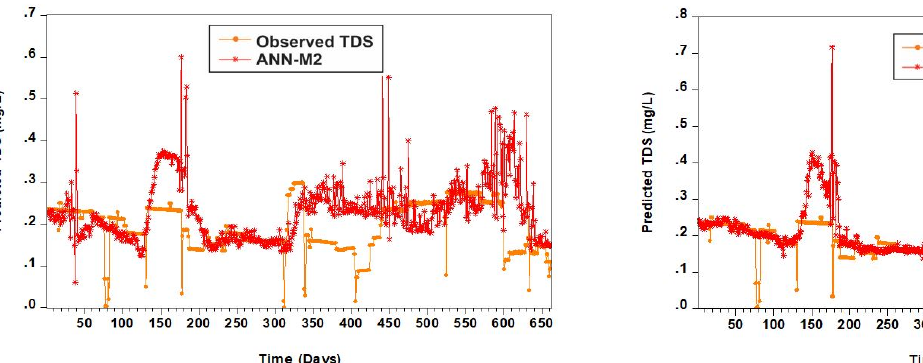
Figure 6. Time series plot for ANN-M2, ANFIS-M2, SVM-M2, and MLR-M2. According to the time-series plots, it was evident that the best predictive model was M1, since the prediction trend was closer to the observed TDSt. Similarly, the trends of the observed and predicted values for ML models were found to be close to each other. The MLR models, on the other hand, revealed a discrepancy in the trends of observed and predicted values. Furthermore, the time series of the models differ from one combination to the next, implying that the vibrational pattern of the M models is determined by how they capture the relationship between the observed and target parameters. From the above figures, it can be justified that SVM-M1 captures the pattern of the time series more than the other models, with MLR-M2 being the worst model. The uniqueness of the good- ness-of-fit could be indicated in the radar chart. On the other hand, it is important to in- volve two or more performance criteria to come up with a justifiable argument. The radar plots describing the R and R 2 values for all the models are shown in Figure 7.